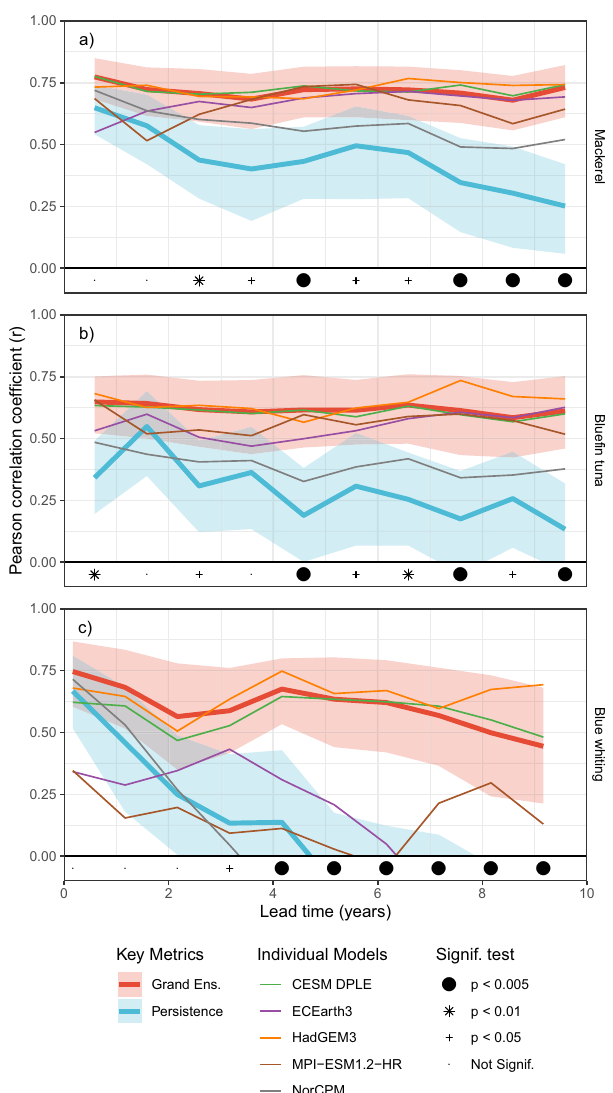
Fig. 2 Fish habitat can be skilfully forecast. Forecast skill for the area of suitable a mackerel, b blue fi n tuna, and c blue whiting habitat. Forecast skill is given as the Pearson correlation coef fi cient ( r ) between the forecast habitat area and that derived from observational data, and is plotted as a function of forecast lead time into the future calculated across the appropriate comparison periods. Forecast skill is shown for the mean forecasts of the individual models (light coloured lines) and for the grand- ensemble forecast across all ensemble members (heavy red line). The skill of persistence forecasts (heavy blue lines) are also shown for reference. Shaded areas for both these key metrics denote the 90% con fi dence interval estimated by bootstrapping: 5% of the distribution is therefore above and 5% below the shaded areas. The hypothesis that the grand- ensemble forecast outperforms persistence (i.e. a one-tailed test) is tested for each lead time, and denoted with symbols at the bottom of each panel. Source data are provided as a Source Data fi le: exact p values are available in this source